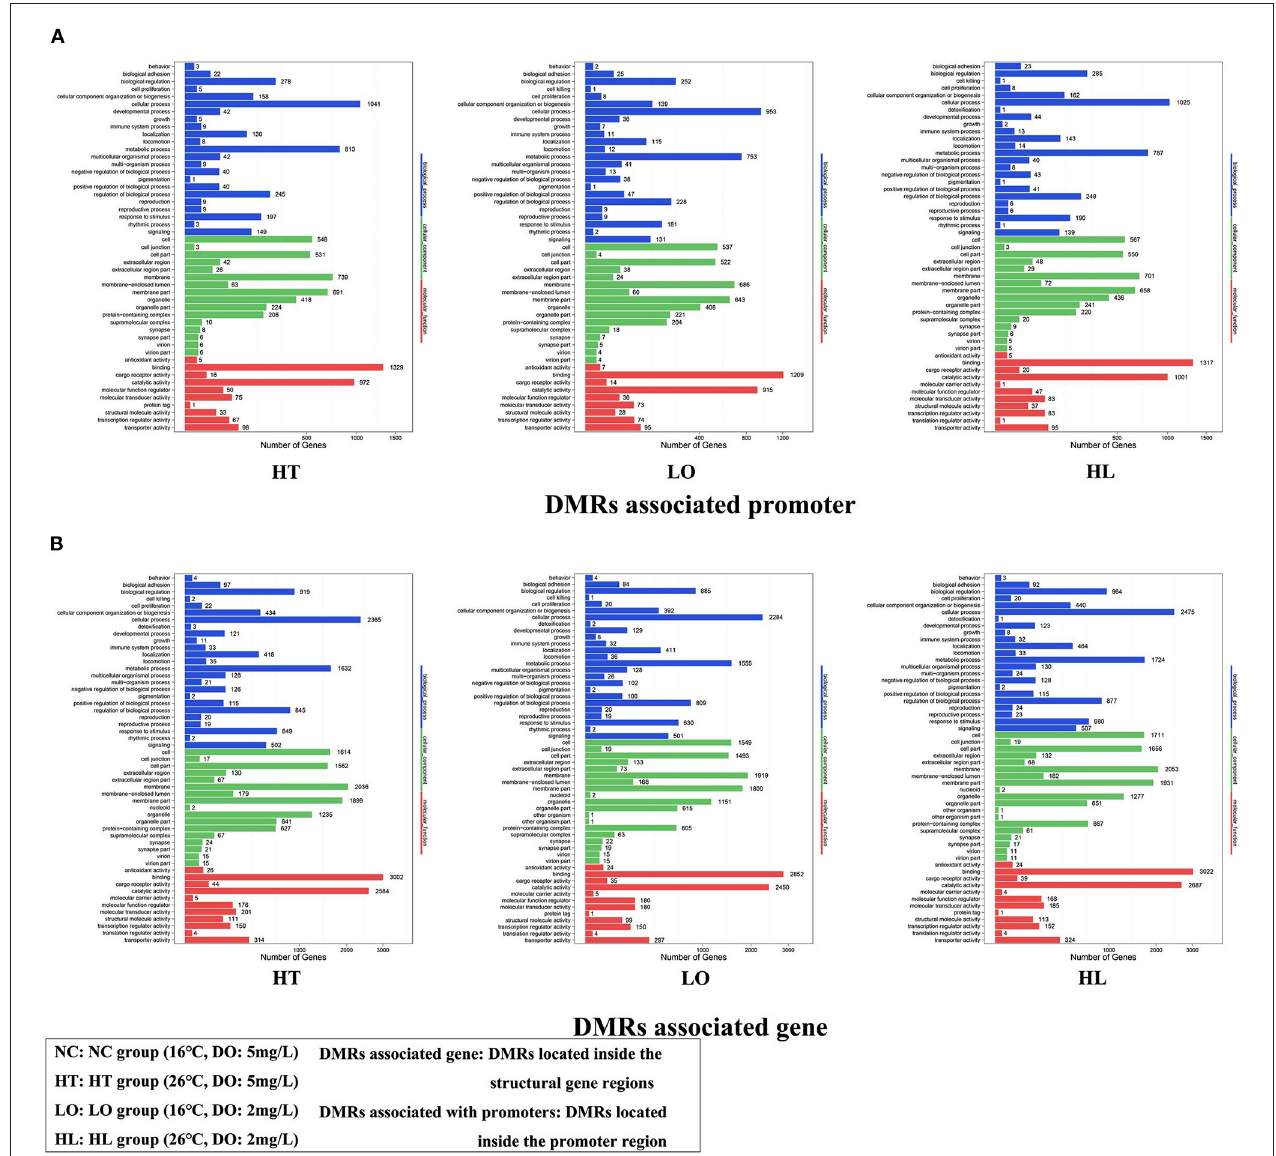
FIGURE 2 | (A) Gene ontogeny (GO) assignments of DMRs associated promoters of HT, LO, and HL groups compared with NC group. (B) GO assignments of DMRs associated genes of HT, LO, and HL groups compared with NC group. The abscissa represents the number of genes or promoters associated with methylation, and the ordinate represents the GO terms. Different colors represent the three GO terms, such as cell components, biological processes, and molecular